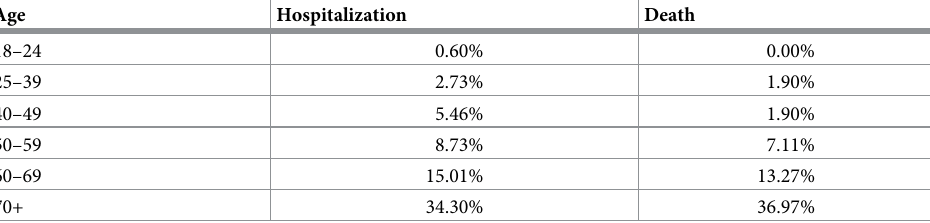
Table 1. COVID-19 hospitalization (given infection) and death (given hospitalization) rates by age in the county in which our example college is located. This data is taken from a publicly available county web